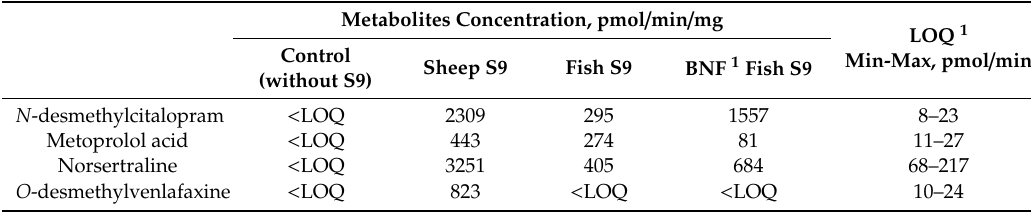
Table 2. Concentrations of metabolites formed under the tested